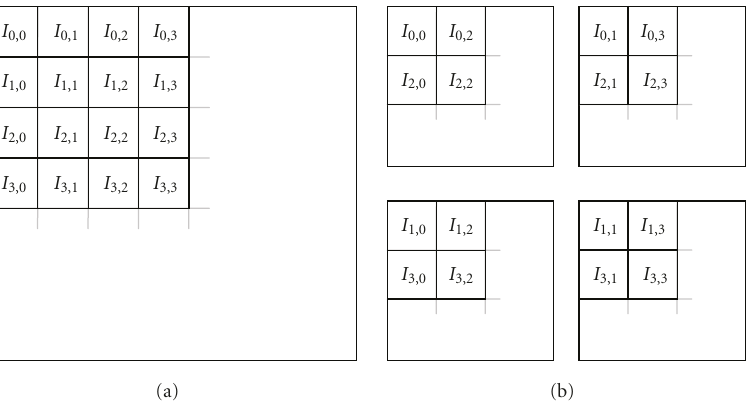
Figure 3: An example of image subsampling: (a) Original image and (b) Four subsampled images.